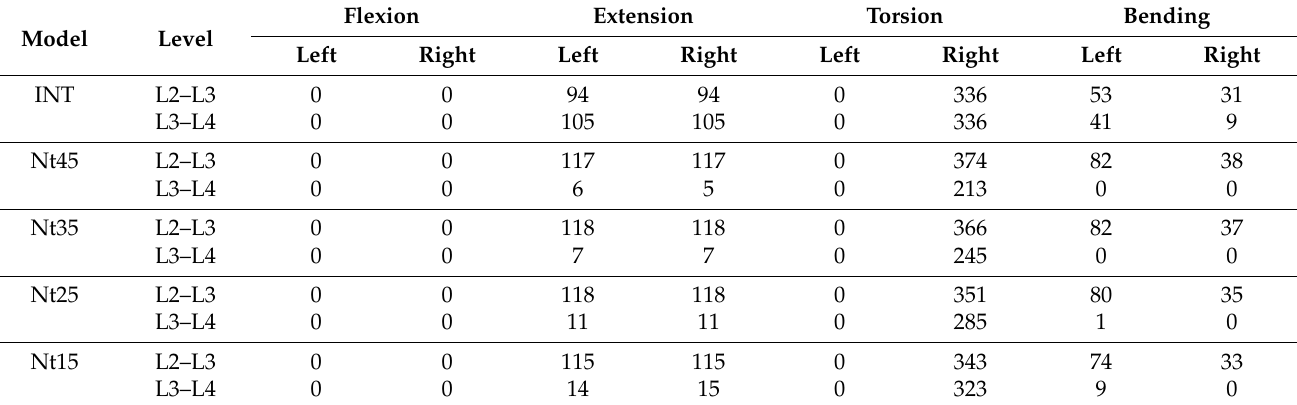
Table 6. Comparison of facet joint contact forces (N) in finite element models.